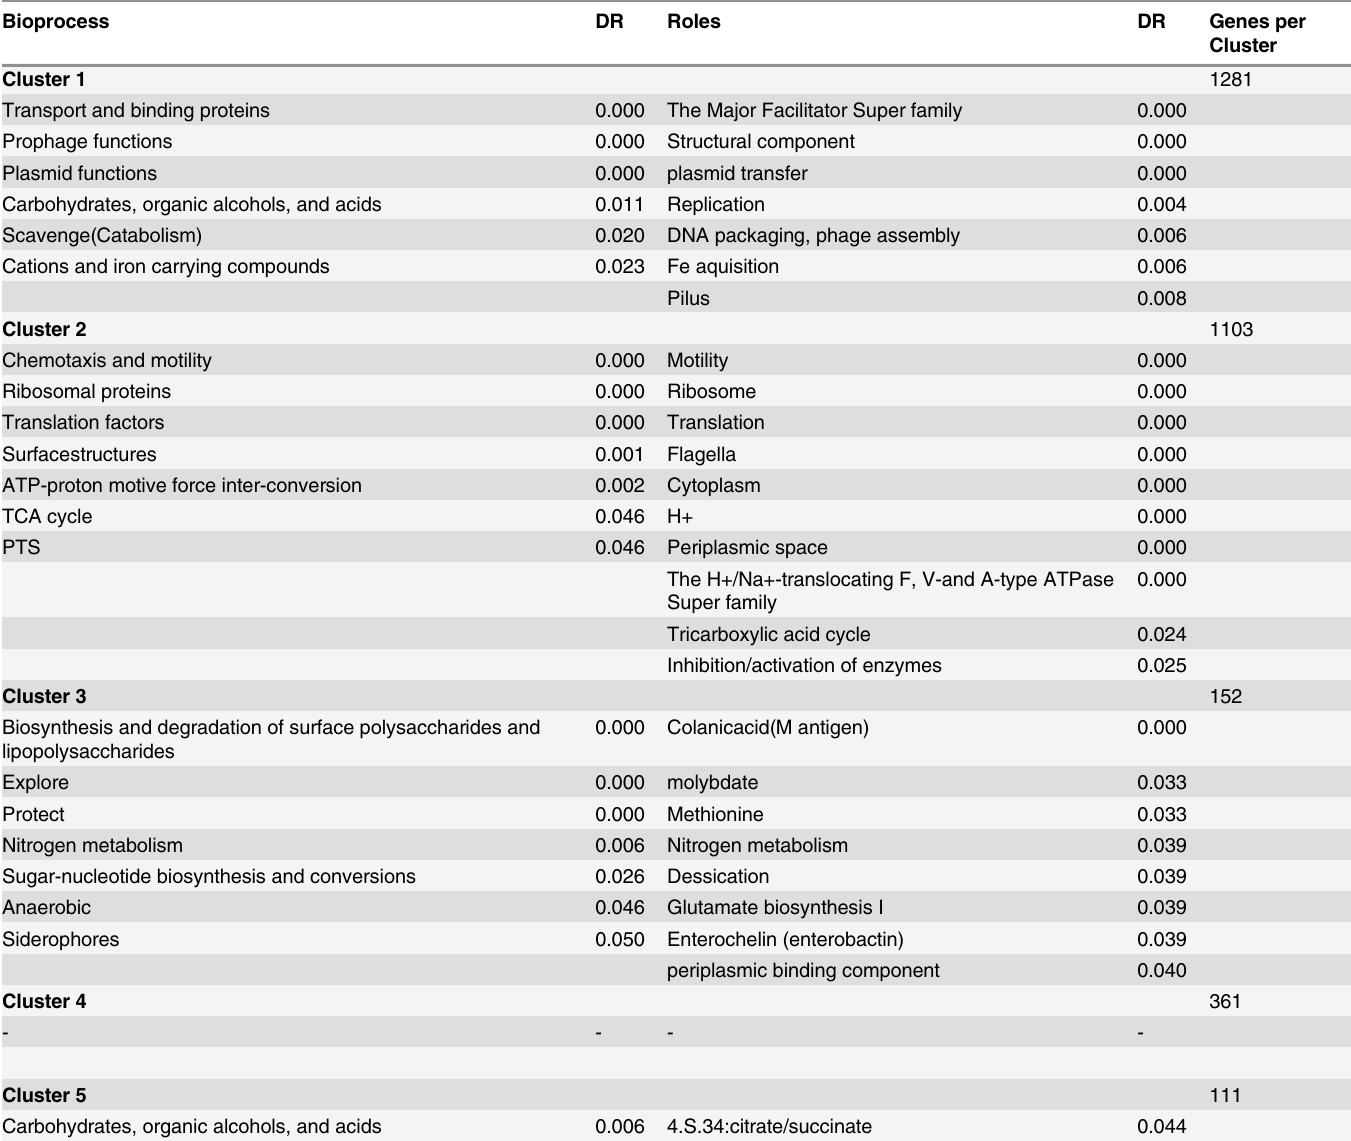
Table 1. Clustering and analyses of functional categories of genes that were differentially expressed on medium with sucrose or lactate as sole carbon source.